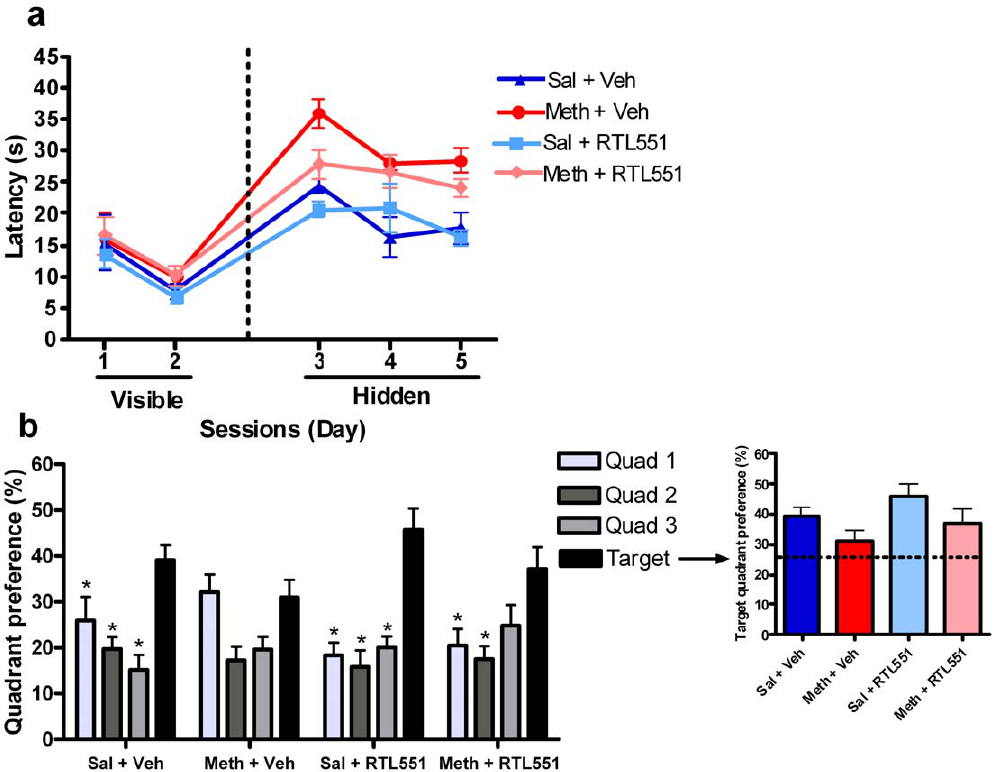
Figure 1. Efficacy of RTL551 over vehicle in the treatment of methamphetamine induced spatial learning and memory impairments (n=8 per group). (a) Training sessions: time spent finding the visible and hidden platforms. Kruskal-Wallis tests revealed no significant treatment group differences across study groups in terms of the latency to find the platform during the visible platform training sessions [Days 1 and 2; p=0.39 (Gaussian approximation)]; this demonstrates that the groups were not significantly different in terms of basic motor function and perceptual abilities. Similar analyses also revealed no significant differences across treatment groups in terms of latency to find the platform during the hidden platform sessions [Days 3–5; p=0.39 (Gaussian approximation)], suggesting that all groups were able to learn the task. (b) Memory test: Quadrant preference during the final 24-hour probe trial. Friedman and Dunn post hoc tests revealed the following differences between the target and the three non-target quadrants: 1) Sal + Veh: Target versus Quadrants 1, 2, and 3 (p , 0.05), 2) Sal + RTL551: Target versus Quadrants 1 (p , 0.05), 2 (p , 0.01), and 3 (p , 0.05), and 3) Meth + RTL551: Target versus Quadrants 1, 2, and 3 (p , 0.05). Collectively, these results indicate that the Sal treatment groups successfully learned where the hidden platform was located during the probe trial. However, in the Meth + Veh group, the percent time spent in each of the quadrants was not statistically different across quadrants, indicating that methamphetamine had induced significant memory impairments in this group. In the Meth + RTL551 group, mice spent significantly more time in the target quadrant than in two out of the three other quadrants, indicating that RTL had significantly attenuated the methamphetamine induced spatial memory impairments in this group. The inset graph illustrates the differences in preference for the target quadrant across all treatment groups. Statistical analysis found that there was a trend toward